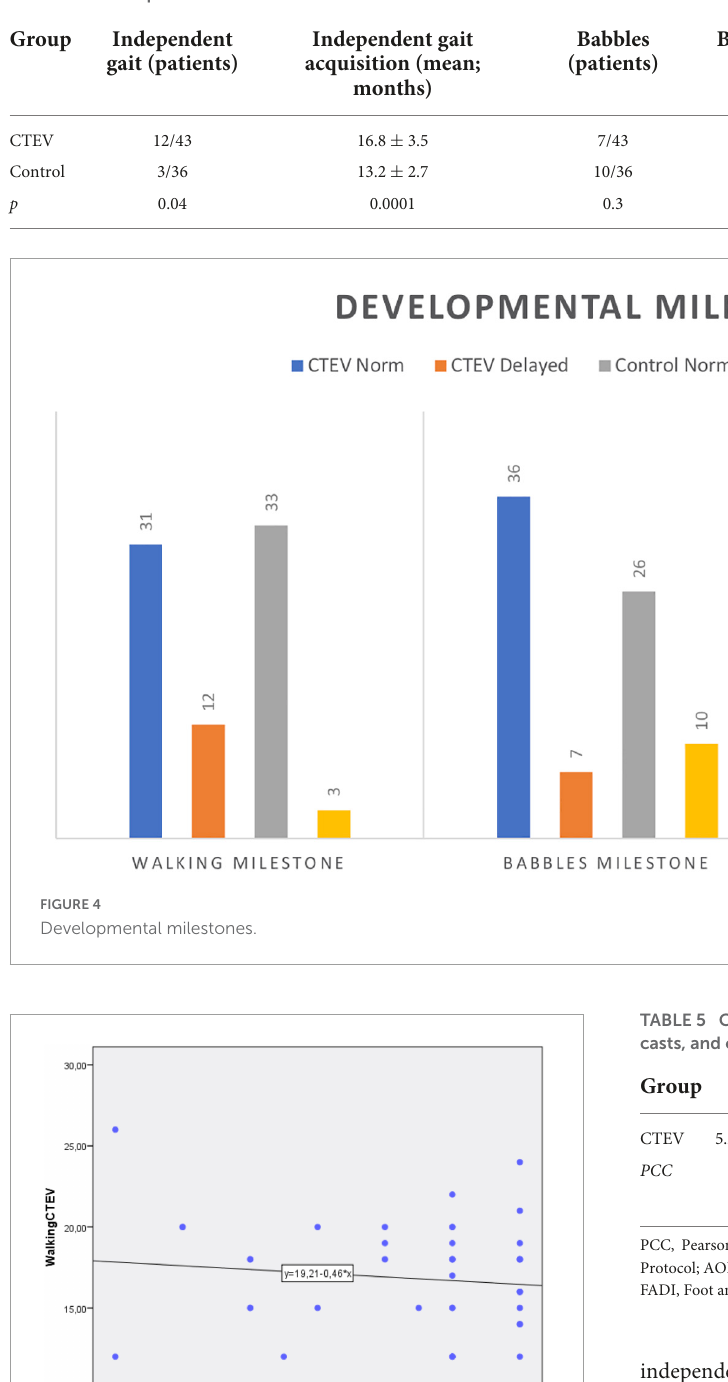
TABLE 4 Developmental milestones.